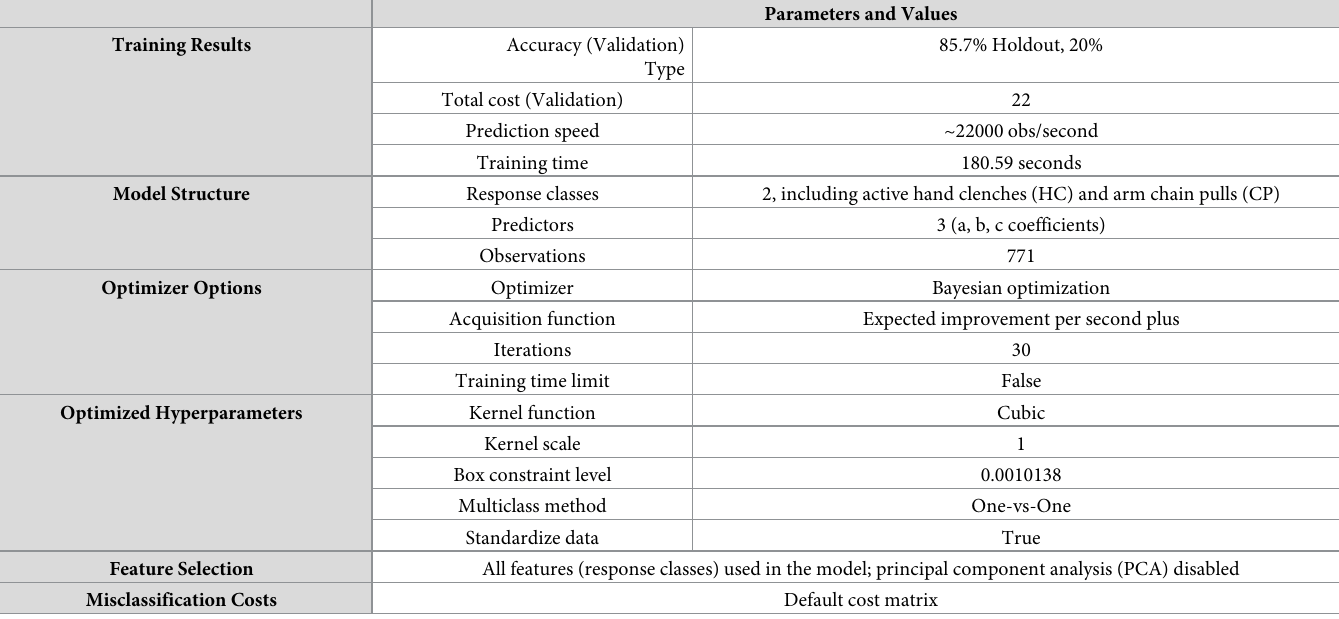
Table 1. Optimizable Support Vector Machine (SVM) parameters and